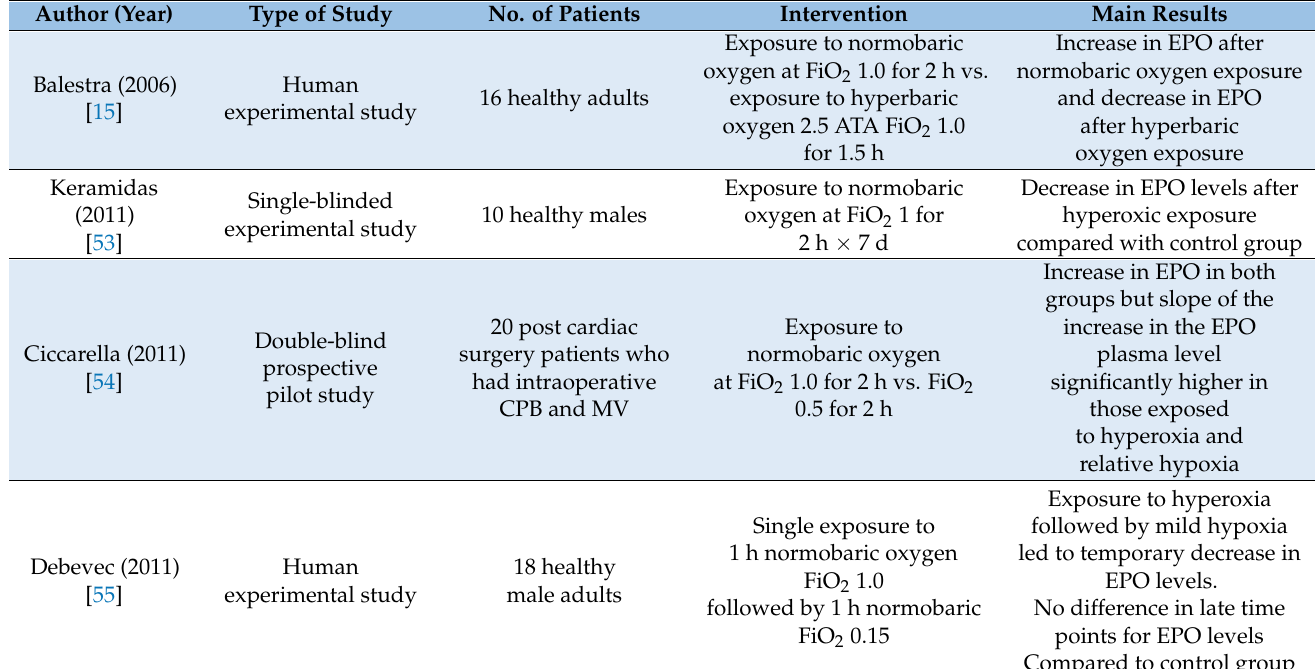
Table 1. A summary of the main human studies on the normobaric oxygen